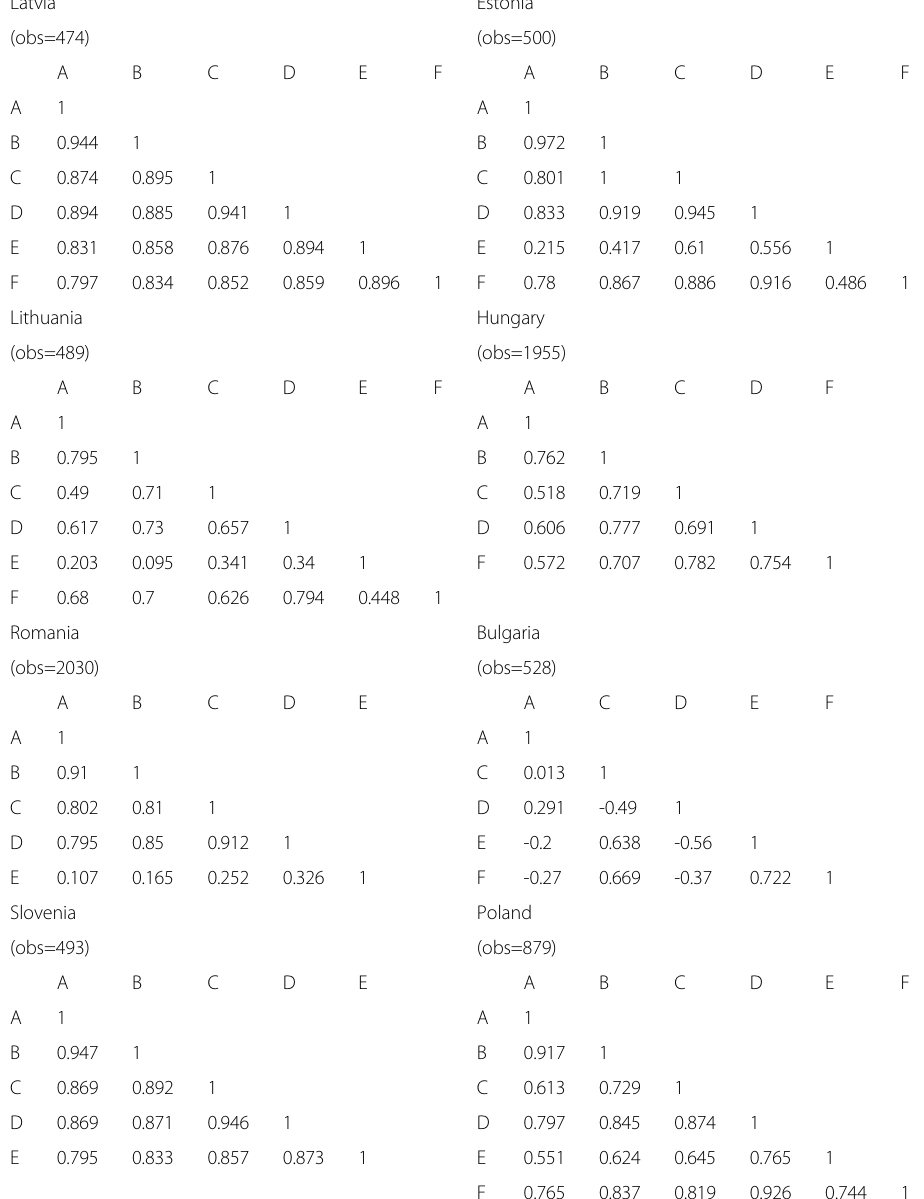
Table 10 Tetrachoric correlations between minimum wage adjustment channels